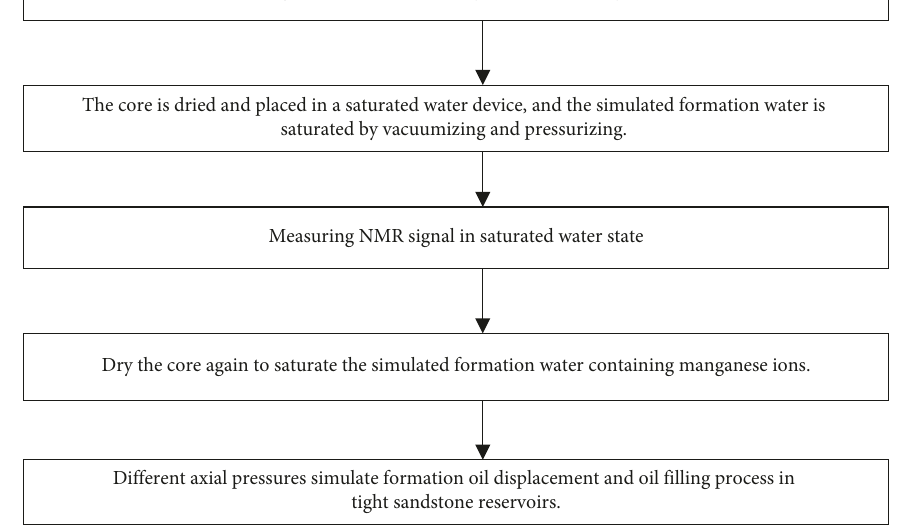
Figure 2: Experimental process of petroleum filling physical simulation experiment.